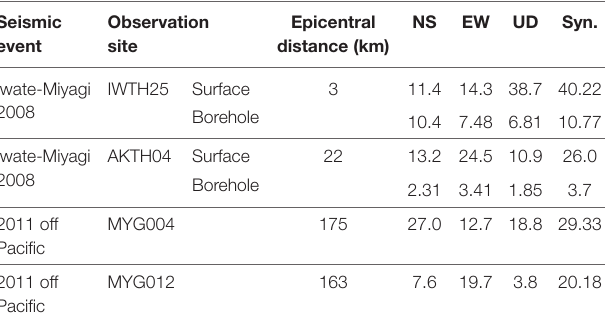
Table 1 | Peak acceleration values over 20 m/s 2